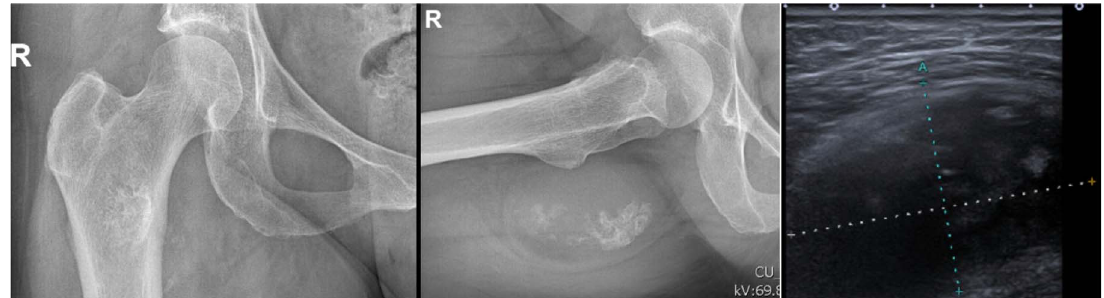
Figure 1. From left to right; plain radiographs and ecchography of the right hip revealing a soft tissue mass with scattered calci fi cations.